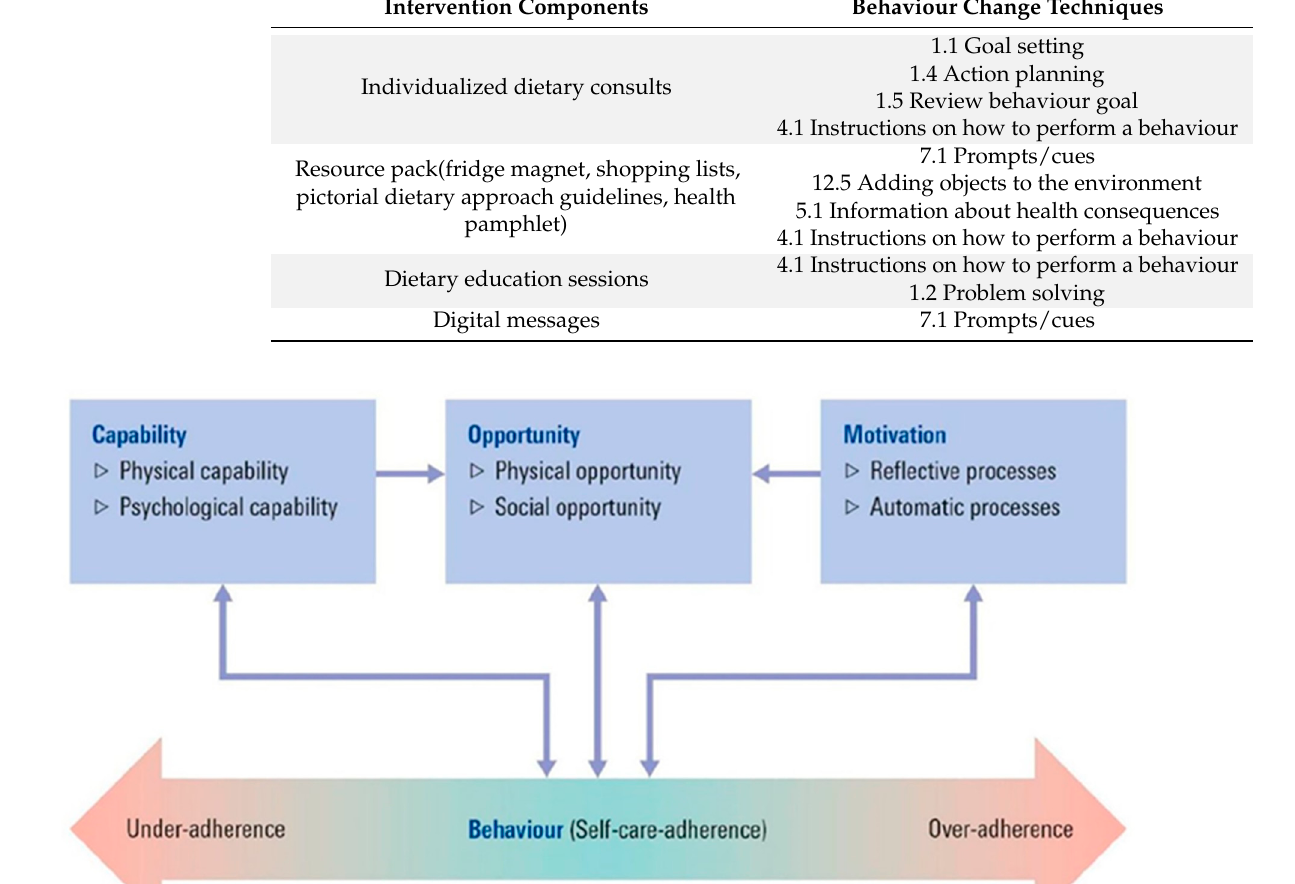
Table 3. Dietary intervention components aligned with behaviour change techniques [59].